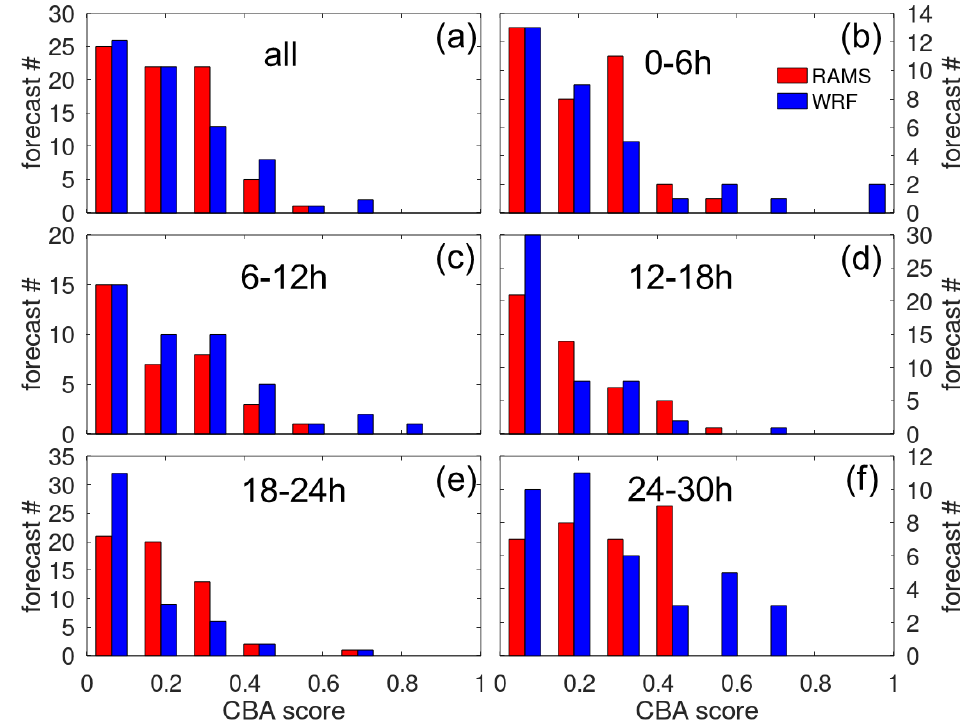
Figure 7. As in Figure 6 but RAMS and WRF CBA forecast scores using RMSE only when CBA exists for both model and the ceilometer.